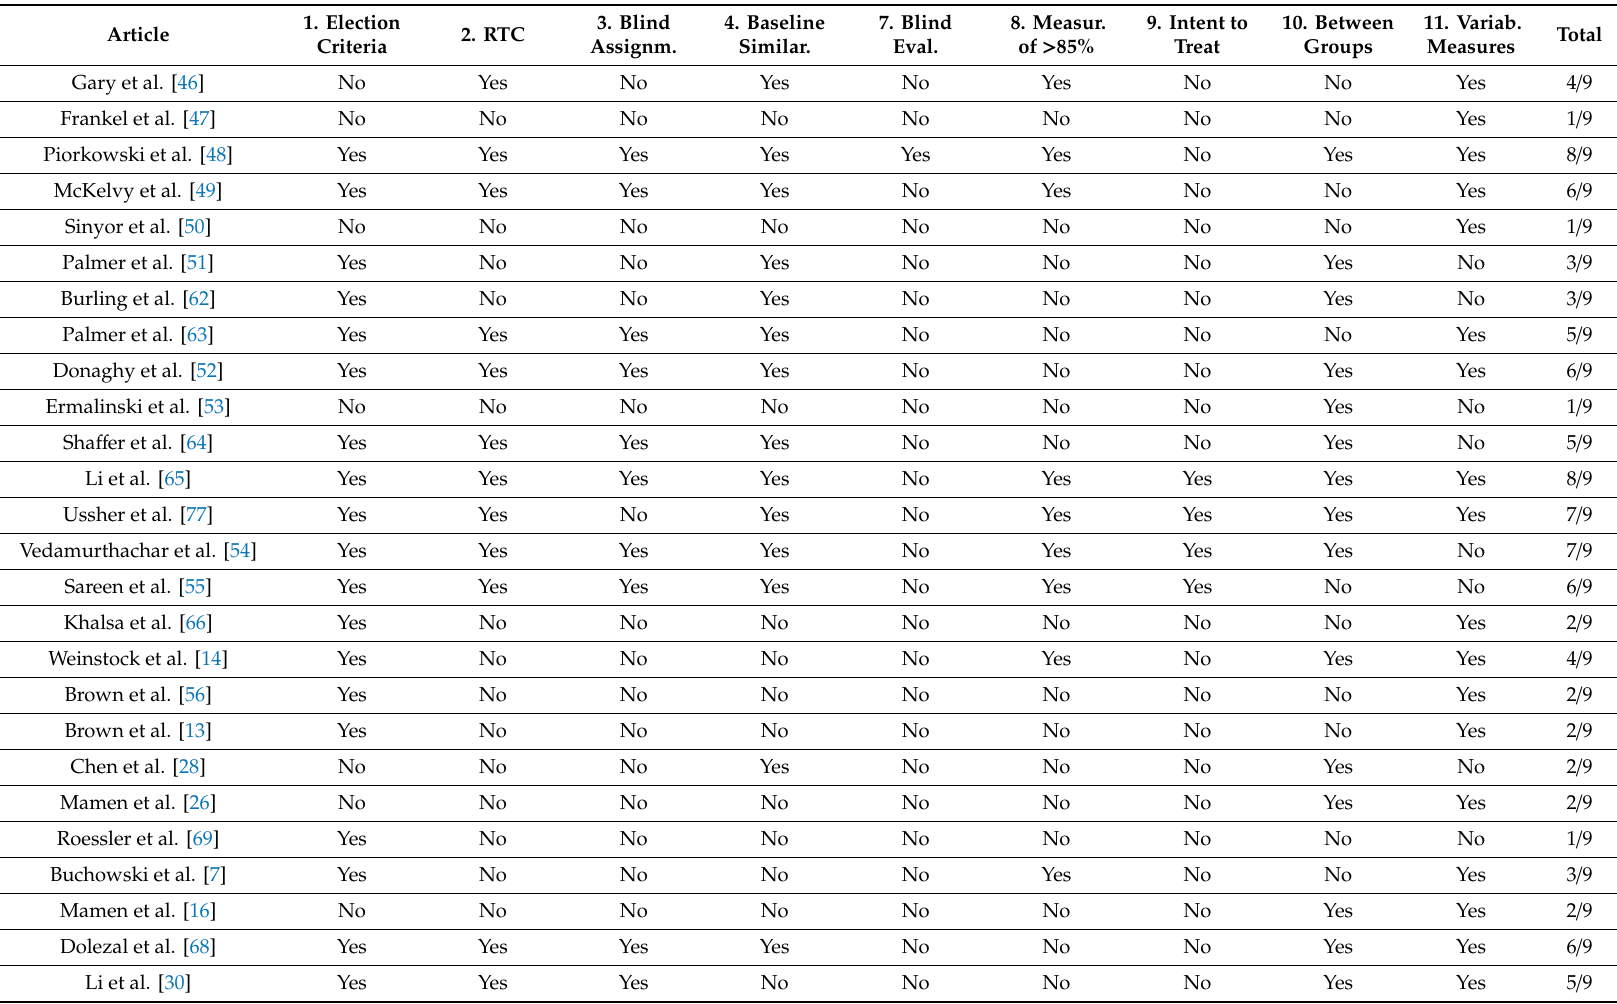
Table 1. Methodological quality of the included studies. (PEDro